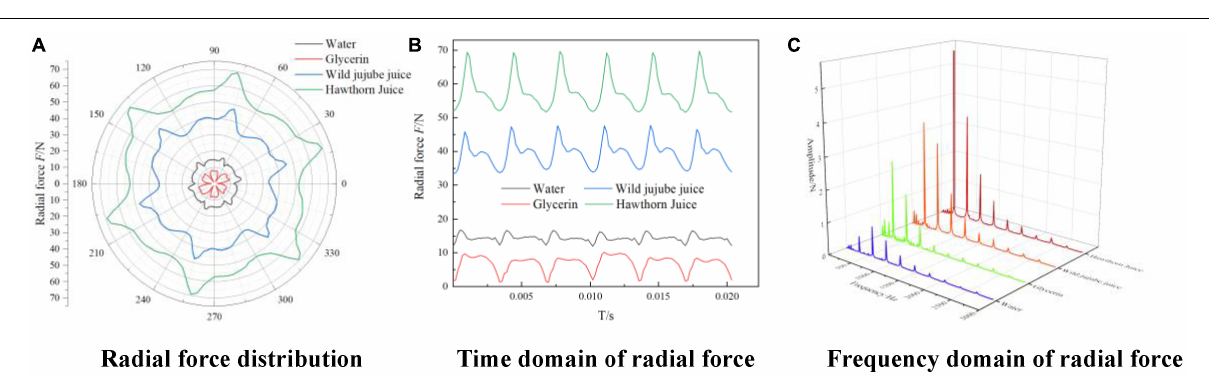
FIGURE 13 | Time-frequency domain distribution of impeller radial force with different viscosities. (A) Radial force distribution, (B) Time domain of radial force and (C) Frequency domain of radial